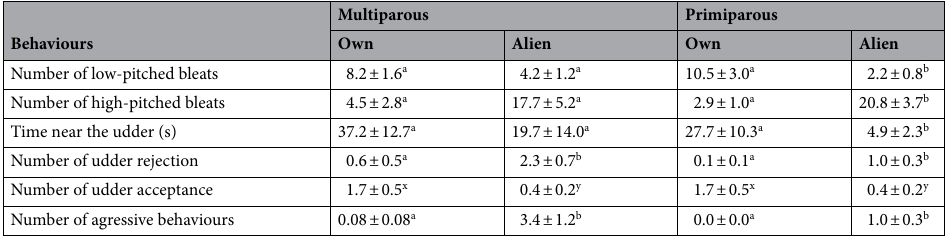
Table 2. Behaviours (mean ± sem) toward the alien or the mother’s lambs during a selectivity test carried out approximately two hours after lambing, in multiparous (n = 12) or primiparous (n = 9) ewes. Means within the same row bearing different letters (a and b) differ significantly ( P ≤ 0.04) or tented to differ (x and y; 0.07 ≤ p ≤ 0.1).